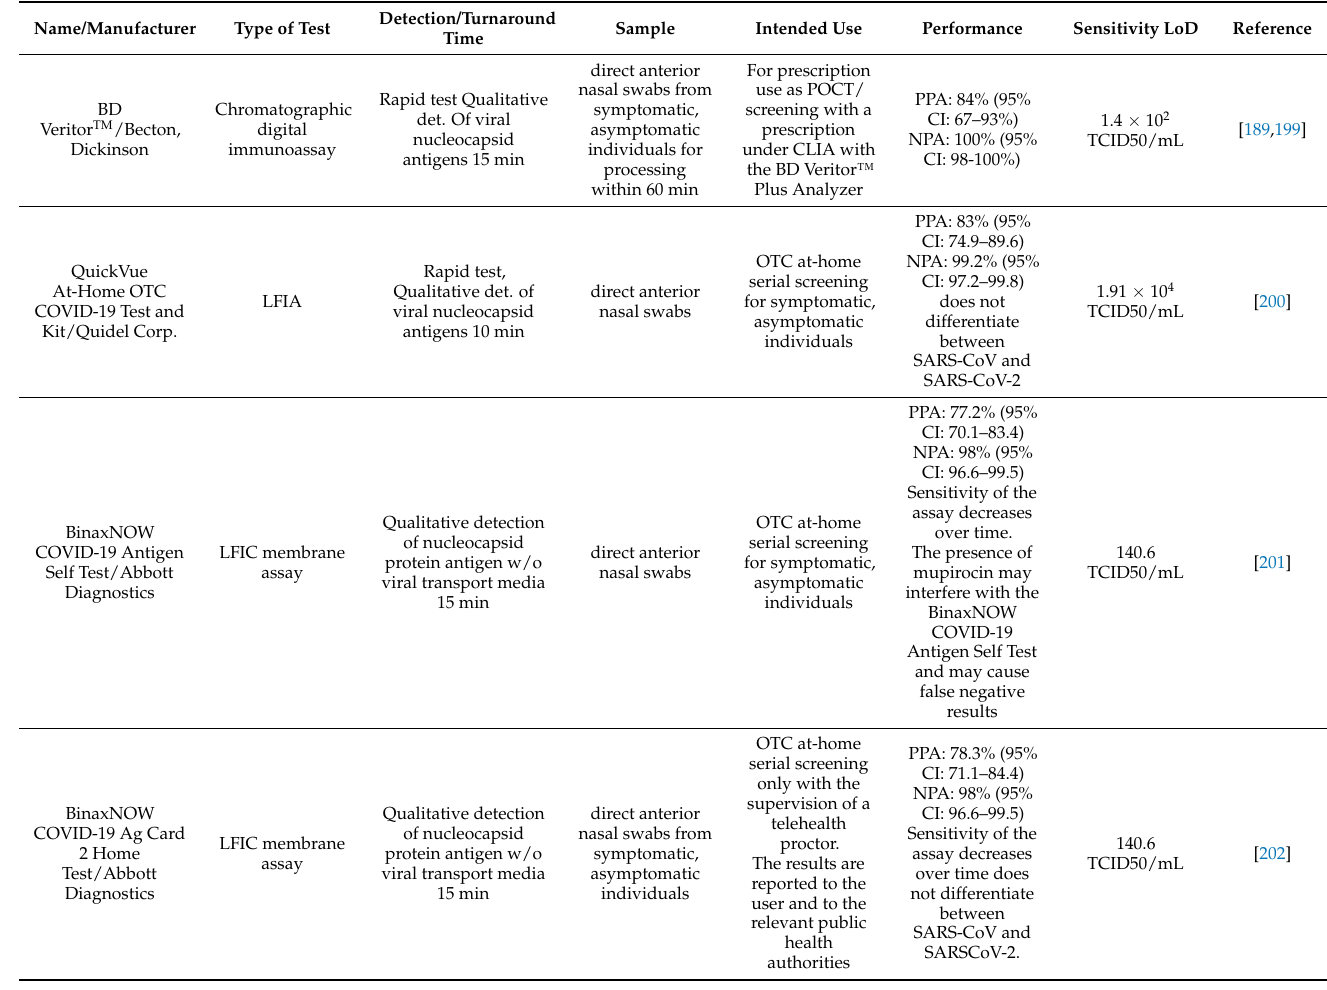
Table 3. Authorised POCT